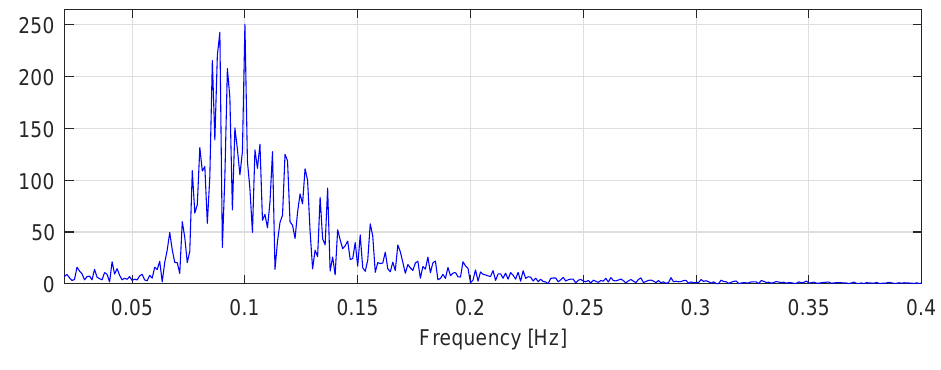
Figure 10. The TMS heave frequency spectre. Table 6. The relationship between depth sensor sampling frequency and ANFIS performance. Sampling